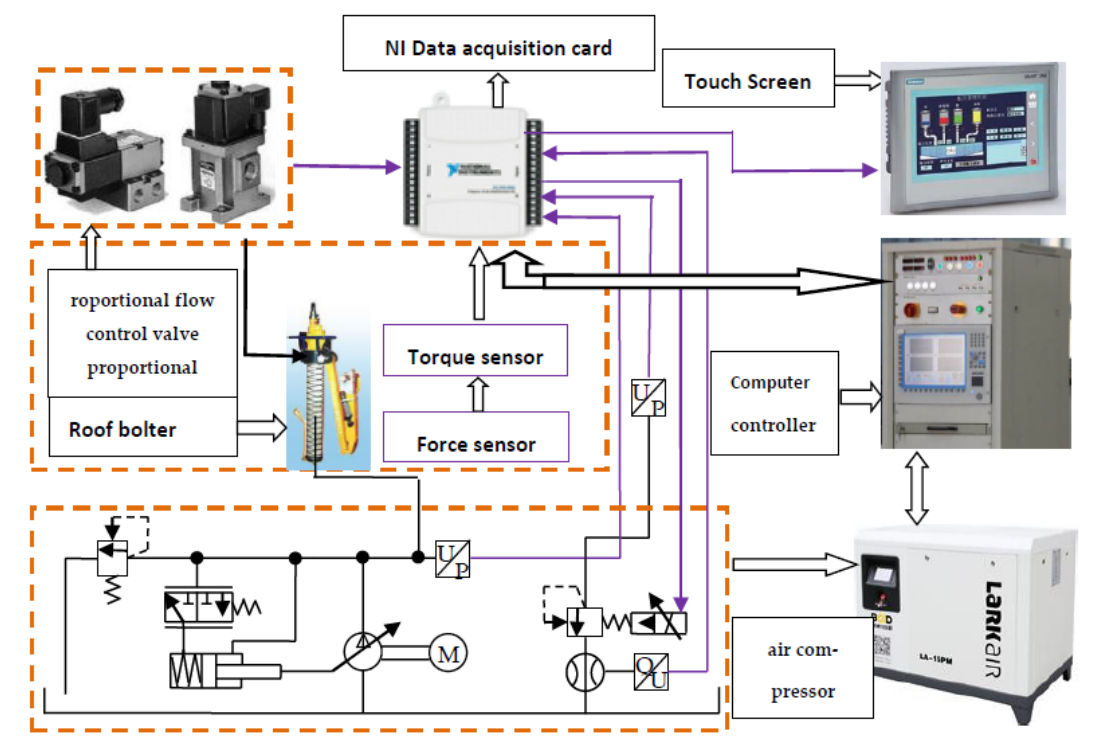
Figure 3. Experimental system of the UCS detector for roadway rock.